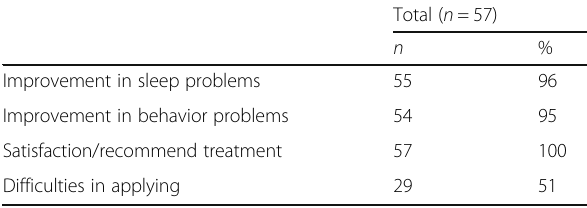
Table 5 Satisfaction to treatment